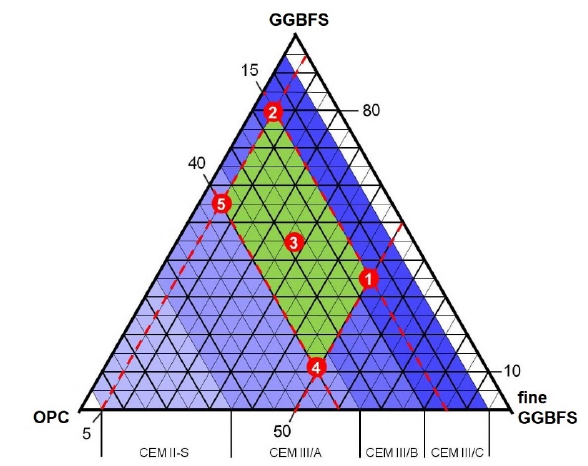
Figure 1. Testing area of the binder compositions.